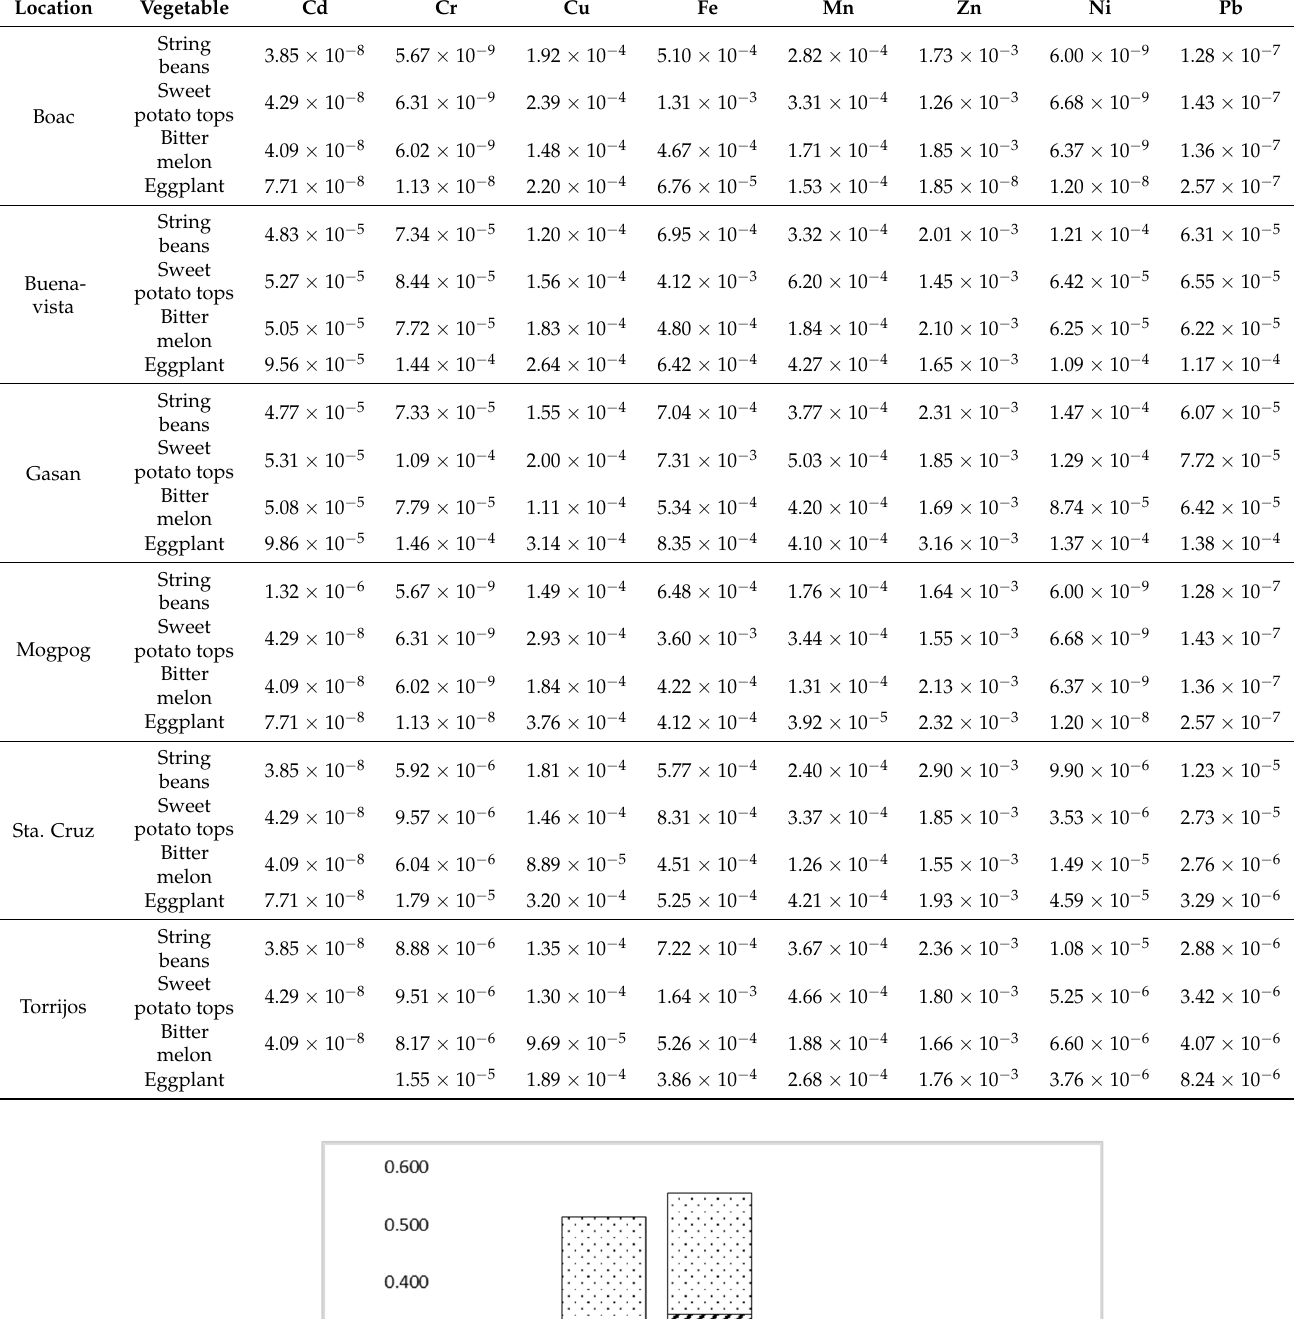
Table 5. The estimated daily intake (EDI) of metals mg kg − 1 day − 1 through vegetables.